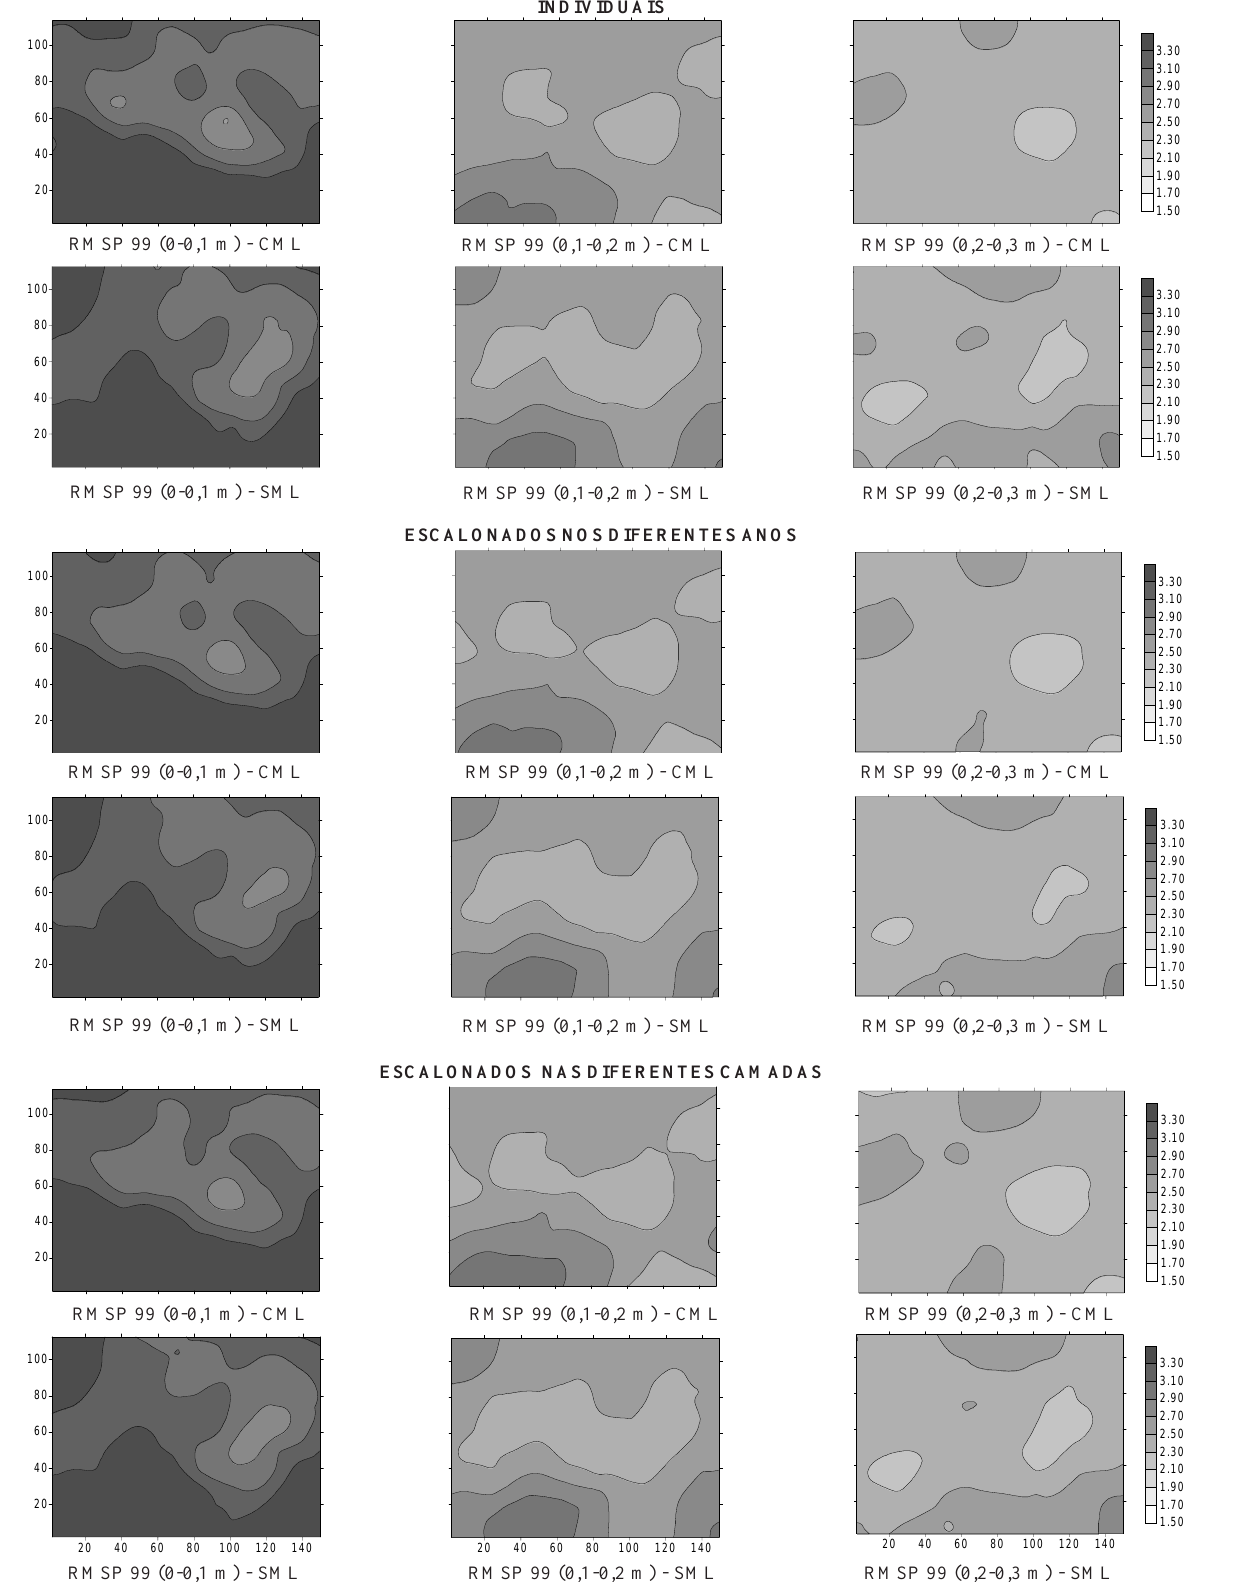
Figura 3. Mapas de contorno da variável RMSP (MPa) do ano de 1999, construídos a partir dos semivariogramas individuais; escalonados nos diferentes anos de amostragem e nas diferentes